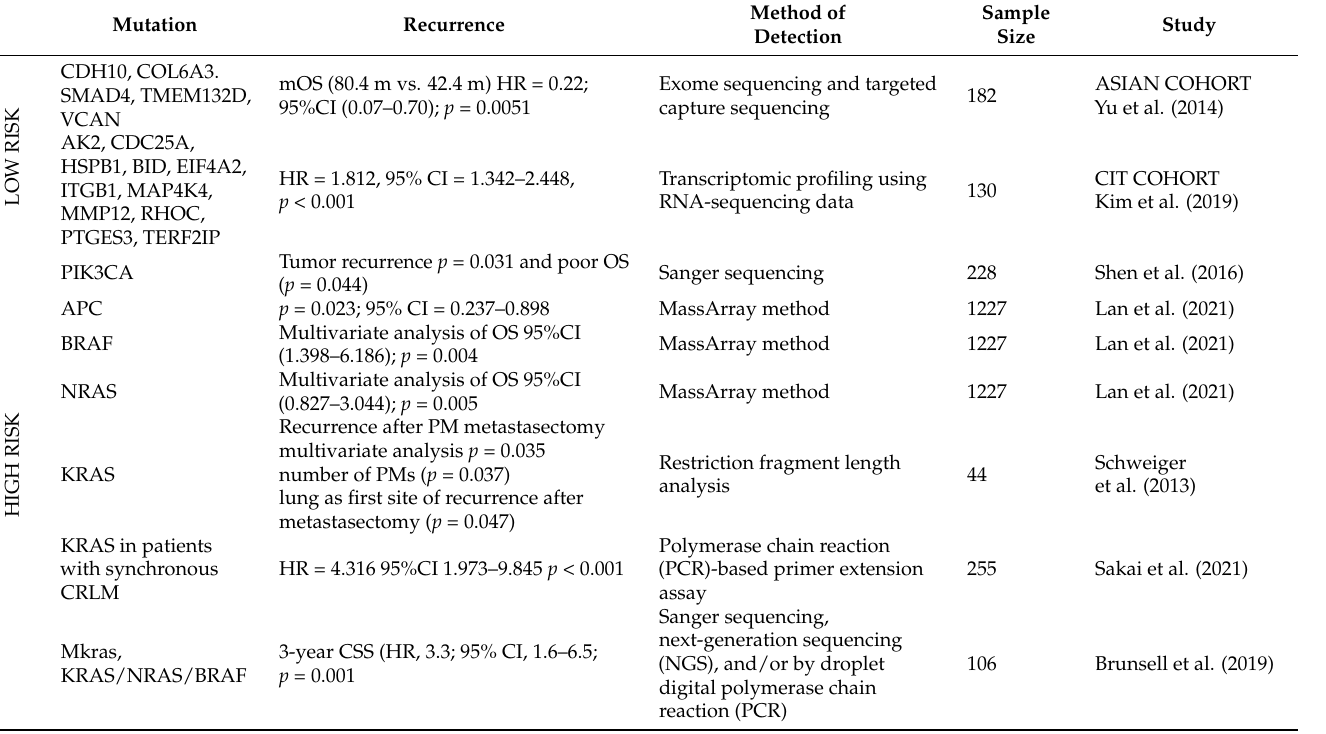
Table 1. An overview of studies associating particular genetic mutations to CRC